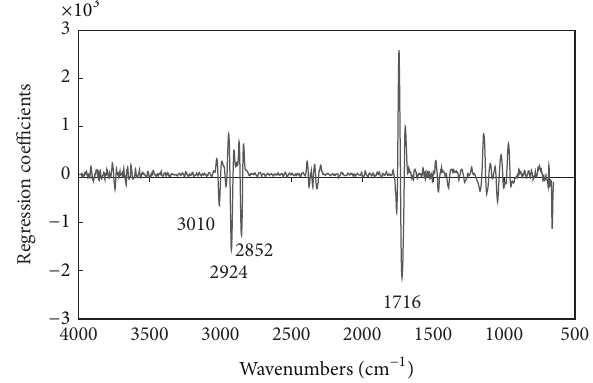
Figure 5: Regression coefficients of the PLS calibration model for AV based on the second derivative spectra.